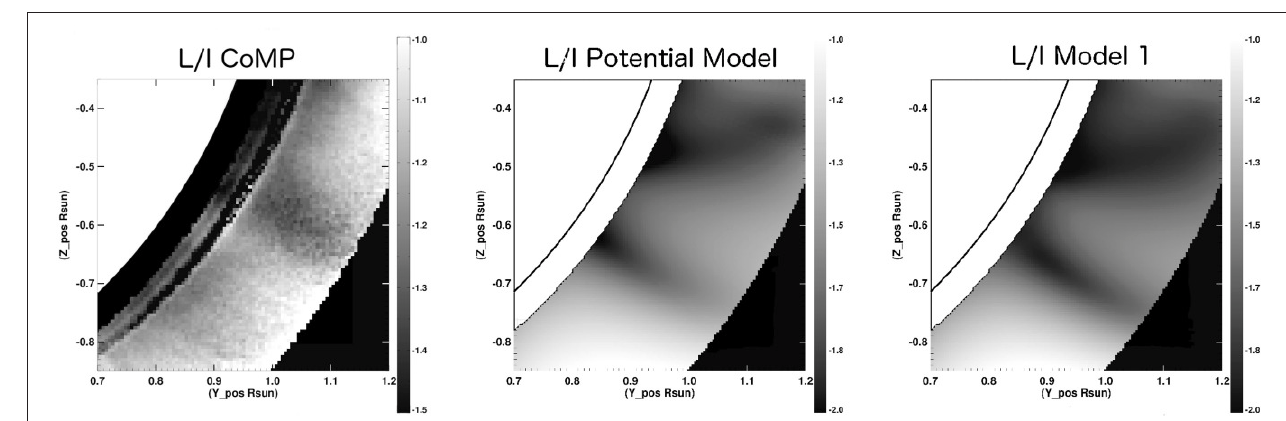
FIGURE 12 | Left: CoMP QuickInvert L / I (log scale) observations of the region of interest at 21:13 UT on 9 October 2014. Middle : Potential field model results L / I with the CoMP field of view. Right : Model 1 results L / I with the same field of view.